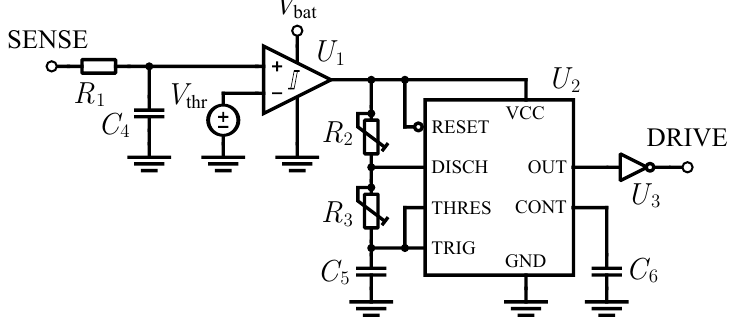
Figure 9. Qualitative diagram of the circuit which controls the operation of the buck-boost